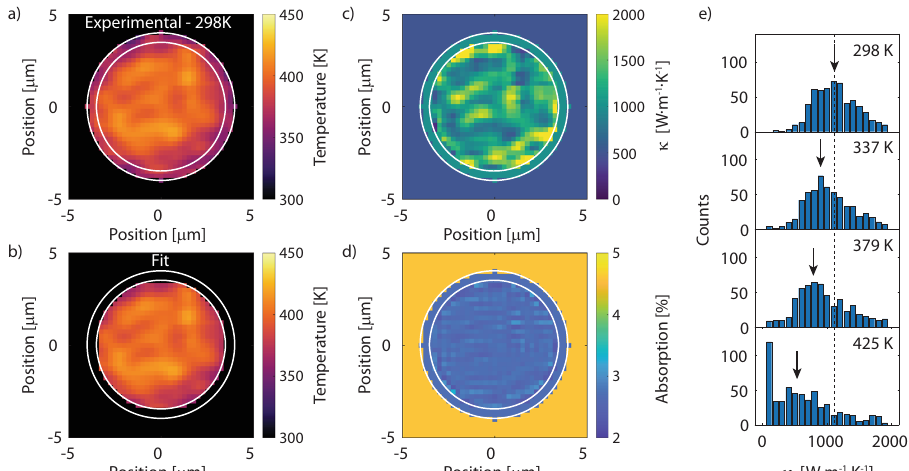
Fig. 4 Thermal conductivity map based on fi tted experimental data. a Experimentally determined temperature map. b Fitted temperature map. c Fitted thermal conductivity map. d Converged absorption map. e Histogram of the thermal conductivity for various hot plate temperatures. Arrows indicate the mode of the smoothed fi tted for the same number of cycles. More details about this procedure can be found in Supplementary Note 2. For numerical stability reasons, we put a lower value on the thermal conductivity at 100 Wm − 1 K − 1 .